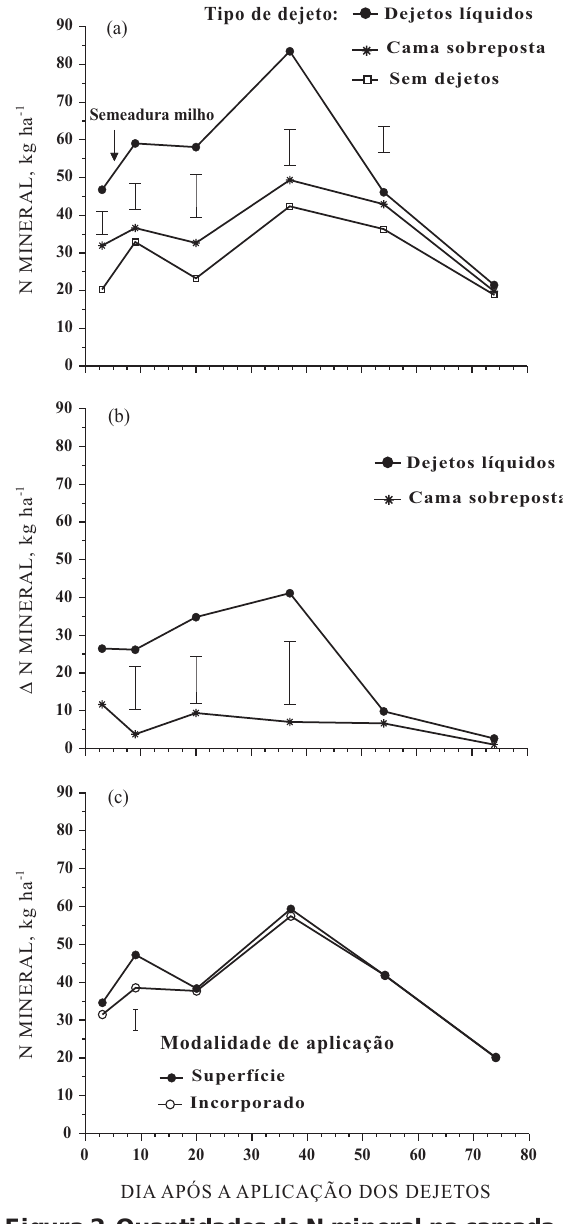
Figura 2. Quantidades de N mineral na camada